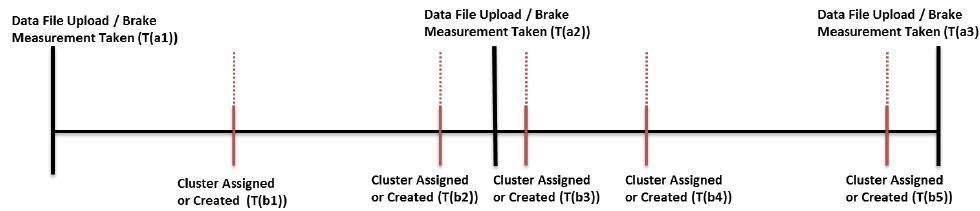
Figure 15. Example of the timeline of events of data upload, clustering triggered by features calculated from cumulative statistics and interpolated through inferred RUL. Figure 16 ( x -axis: odometer) and Figure 17 ( x -axis: cumulative braking distance)